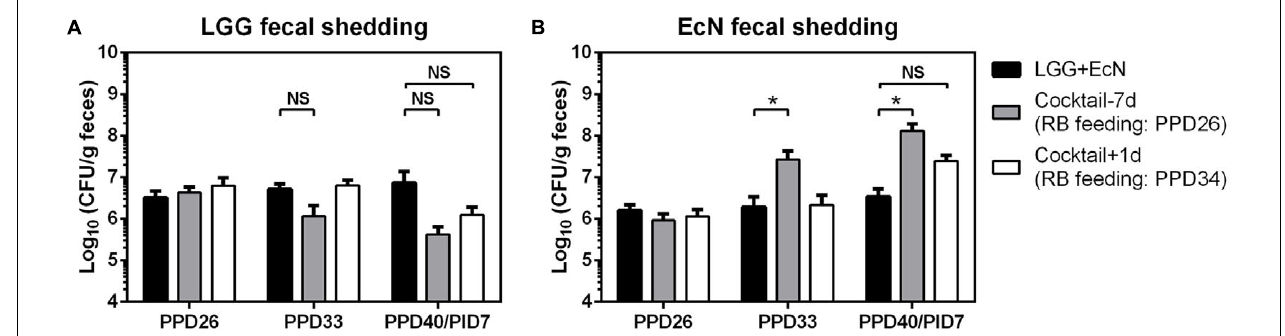
FIGURE 3 | LGG and EcN fecal shedding. Pig feces were collected by rectal swab and suspended in PBS. The concentrations of LGG (A) and EcN (B) were determined in serial dilution of fecal samples and enumeration of colony forming unit (CFU) grown on MRS or LB media agar plates. Sample sizes are shown in Table 1 . Data are presented as mean ± SEM. Statistics were determined by Kruskal–Wallis test. NS, not significant, ∗ P < 0.05.